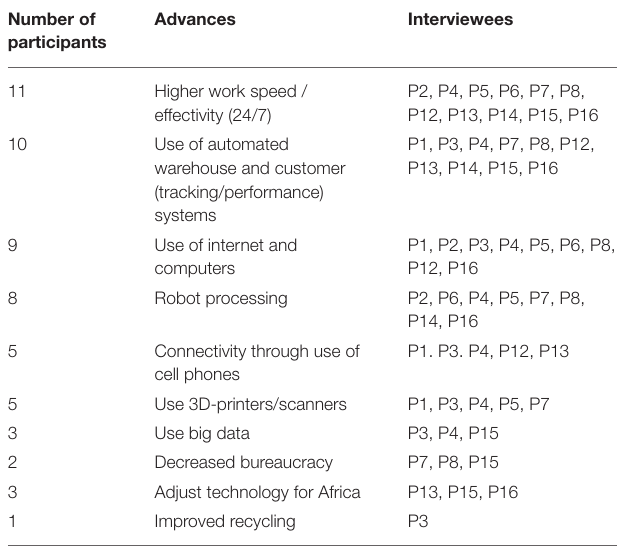
TABLE 2 | Technological advances for sustainable business